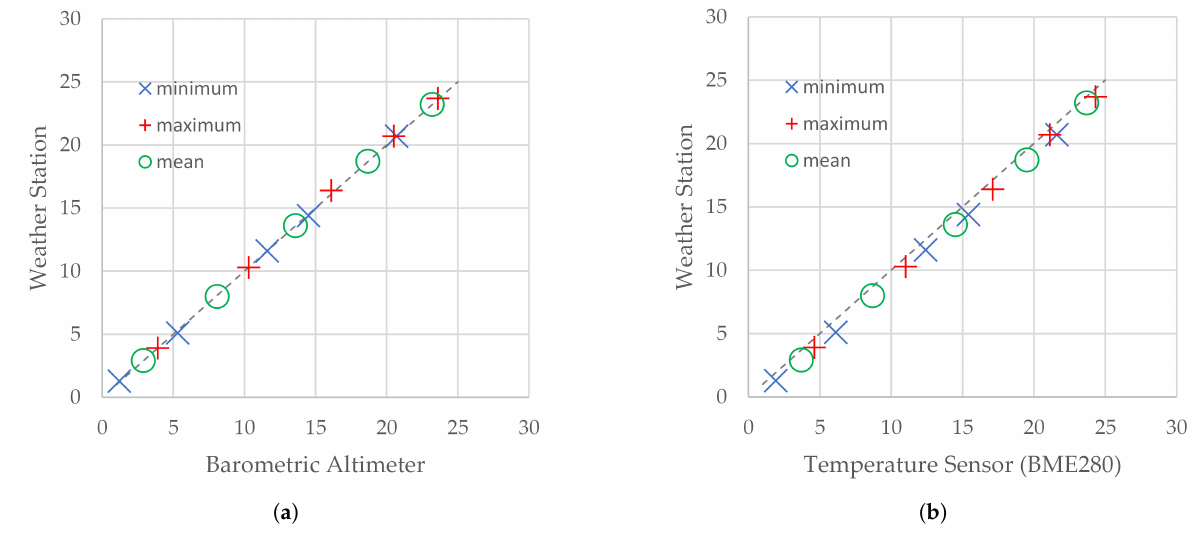
Figure 5. Scatter plots for statistics of temperature measured by the SBS-WS-400 reference weather station and the ( a ) barometric altimeter and ( b ) the BME280.